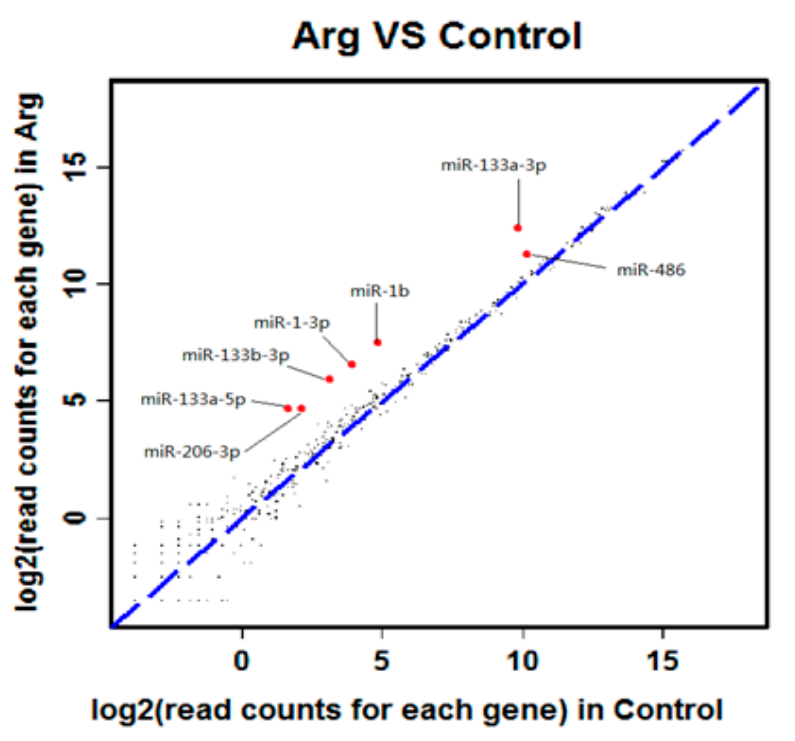
Figure 3. Differently expressed miRNAs (FC < 0.5 or FC > 2).